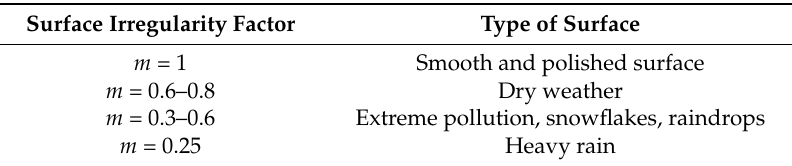
Table 1. Surface irregularity factor m